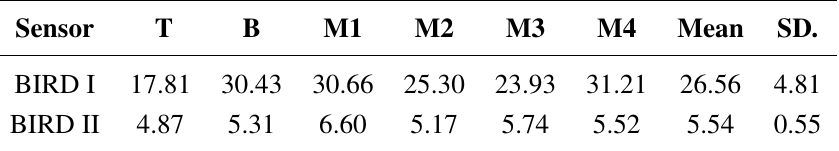
Table 3. Compression force (N) required for 1-mm deformation of BIRD I and BIRD II at six measured